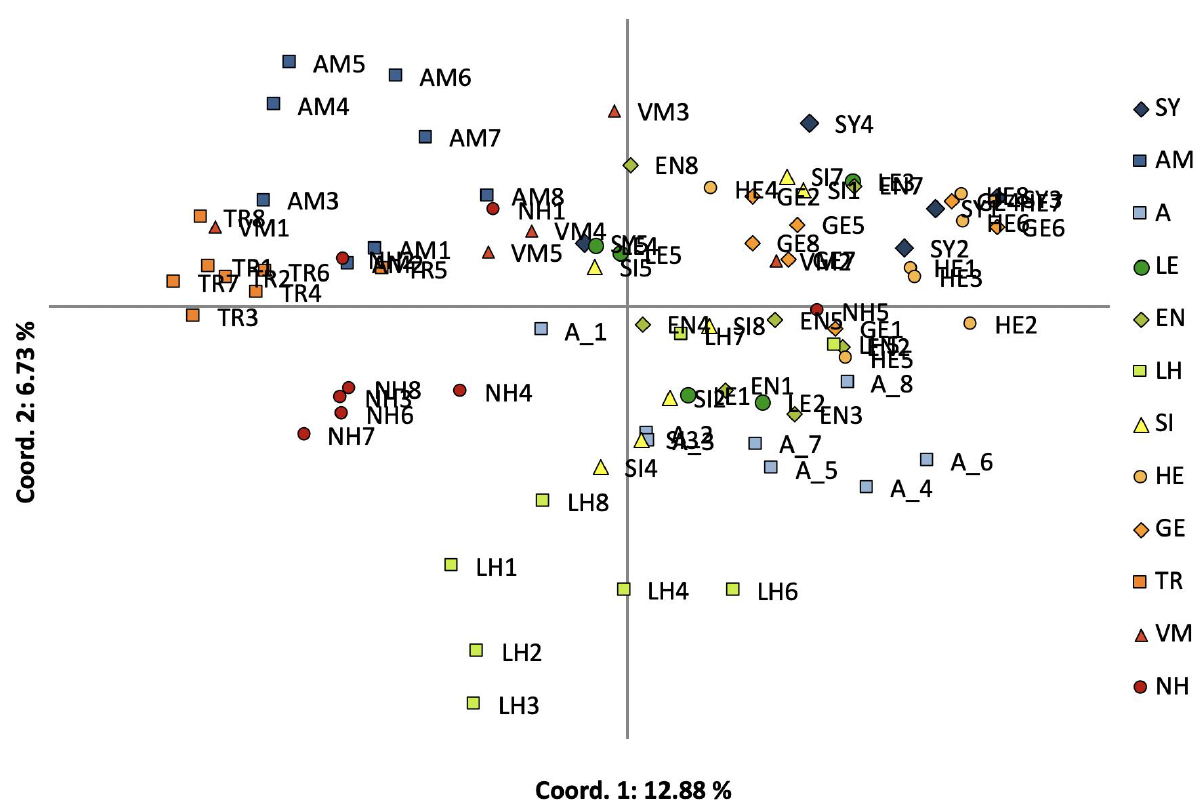
Figure 2. Principal coordinate analysis (PCoA) for genetic distances between individuals of Drosera rotundifolia in Schleswig-Holstein. Sampling regions indicated by colour and aberrations according to Table